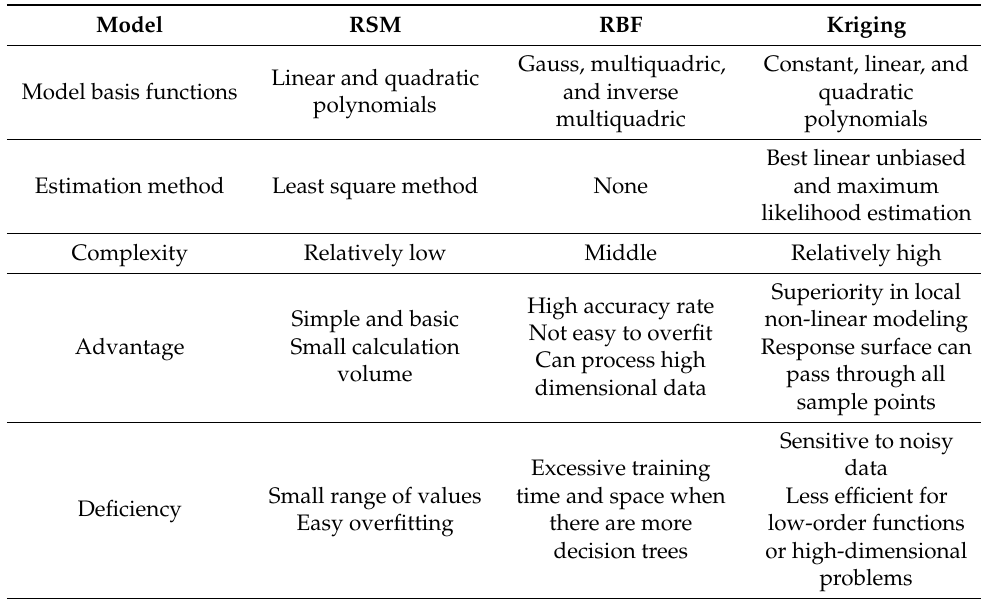
Table 1. Comparison of widely used surrogate